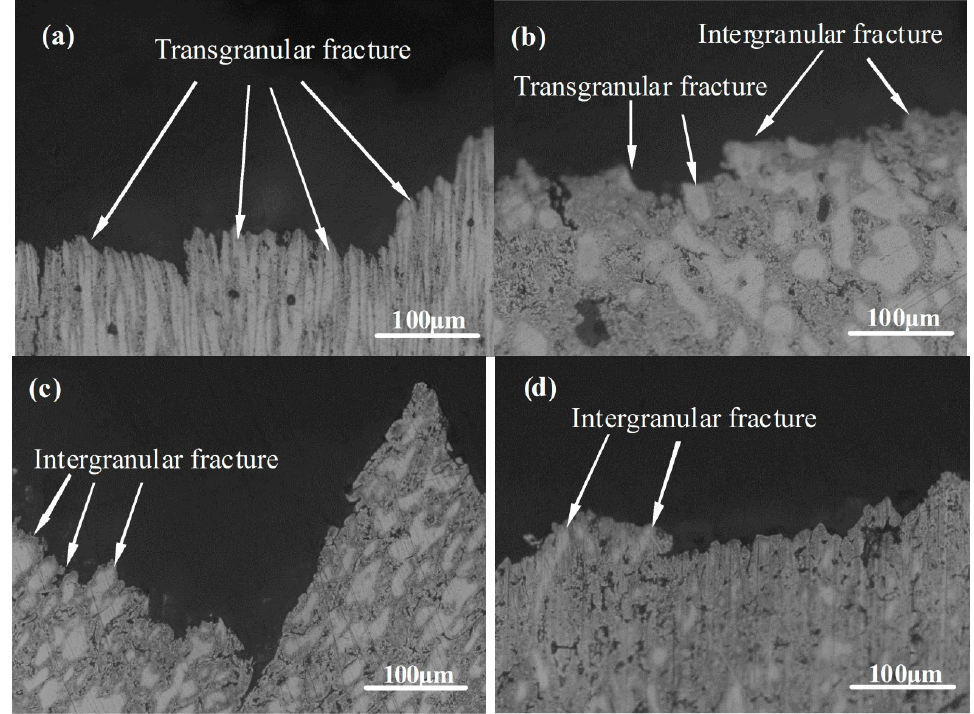
Figure 14. Macrograph of the fracture at the bottom of the thixoformed part soaked for 10 min at different remelting temperatures: ( a ) 580 °C, ( b ) 590 °C, ( c ) 600 °C, and ( d ) 610 °C.